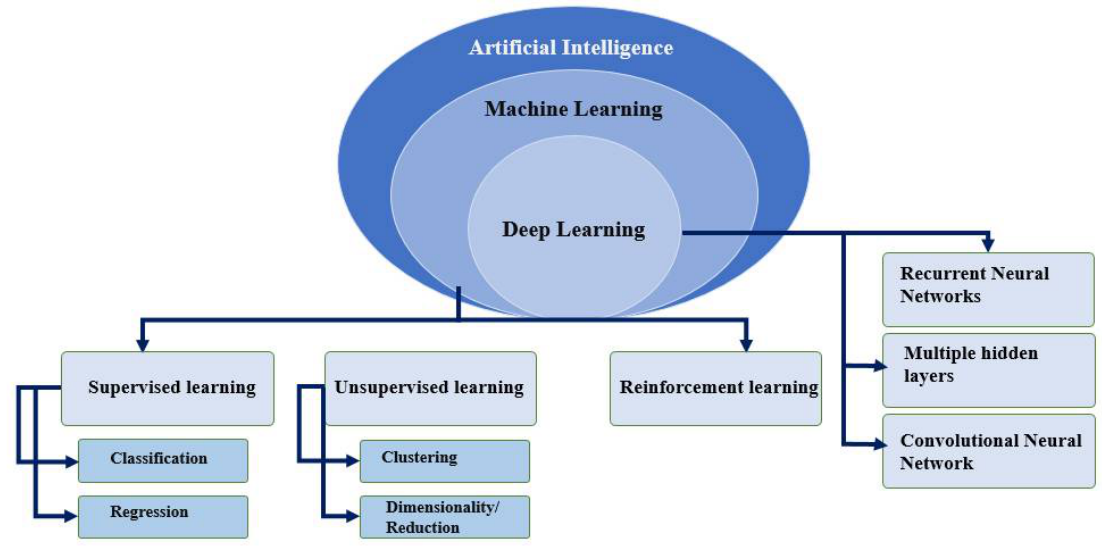
Figure 7. Classification of data-driven techniques and machine learning categories [47] .